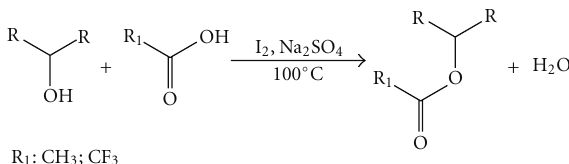
Scheme 1: Acylation